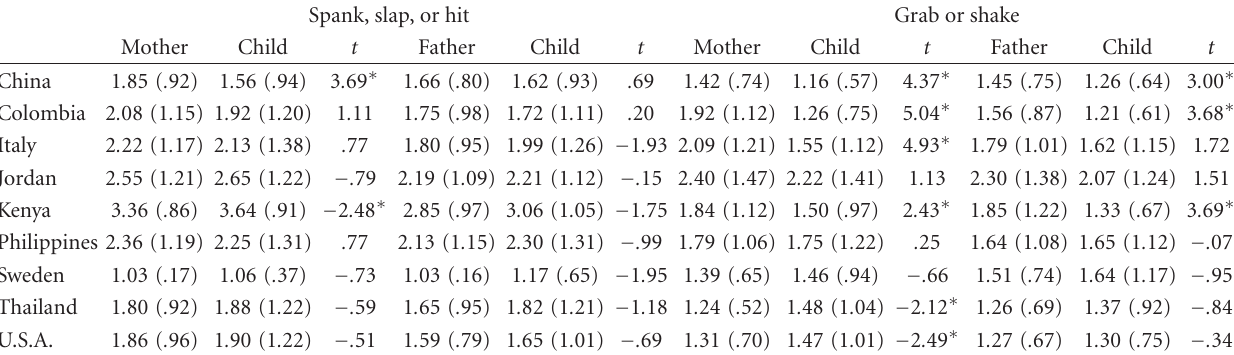
Table 5: Means (standard deviations) for comparisons of parents’ and children’s reports of the frequency of parents’ corporal punishment use in last